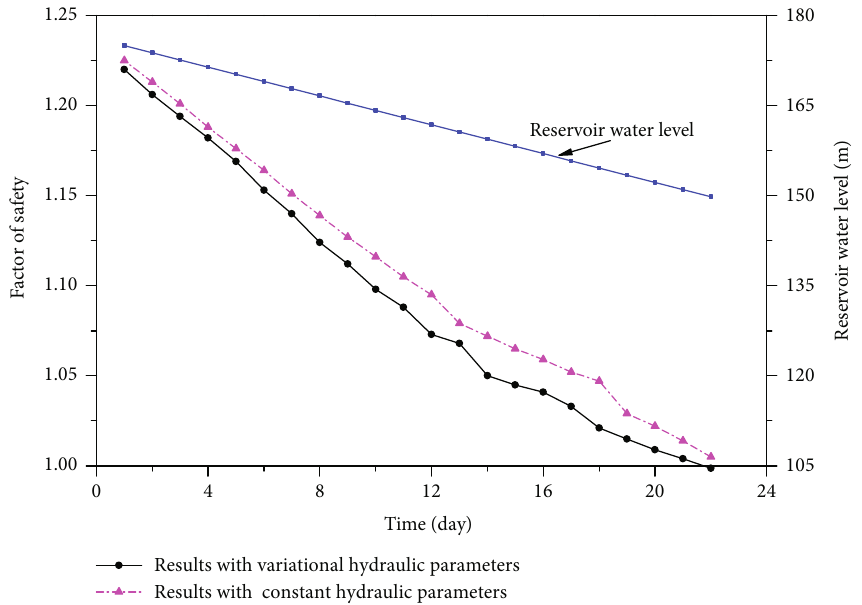
Figure 15: Changes in factors of safety of the slope during reservoir water level drawdown.